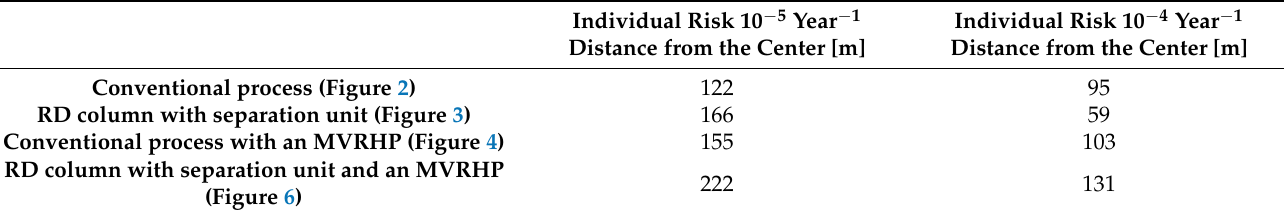
Figure 11. Individual risk of fatality grouped by equipment types: ( a ) conventional process (Figure 2); ( b ) conventional process with an MVRHP (Figure 4). Table 8. Distance from the center of the individual case studies below which the individual risk of fatality is lower than 10 − 5 resp. 10 − 4 year − 1